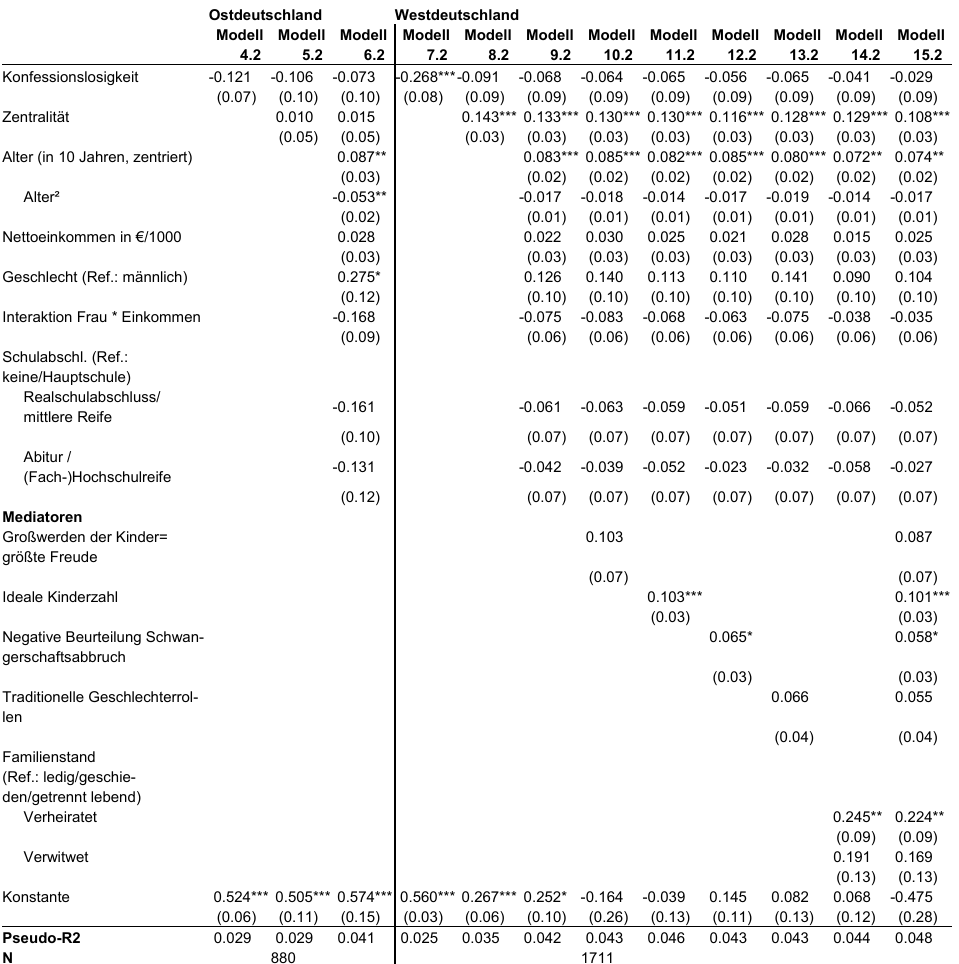
Tabelle 3 : Zentralität und Kinderzahl: Mediationsanalyse (Poisson-logit-Hurdle- Regressionen, 2. Gleichung Truncated-at-zero-Poisson) Ostdeutschland Westdeutschland